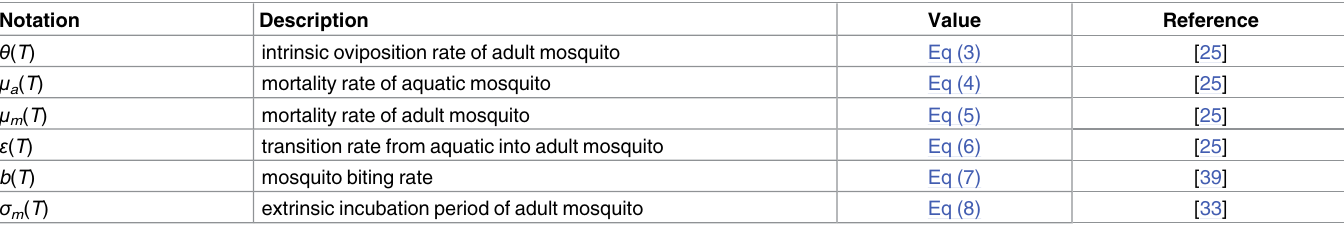
Table 2. Temperature-dependent